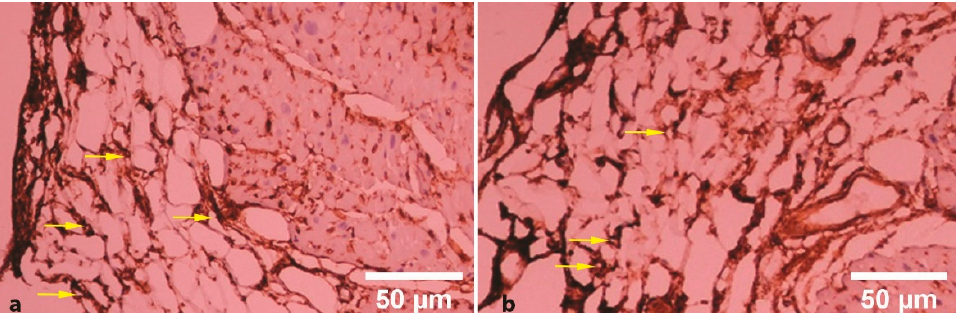
Figure 2. Immunohistochemical EAT analysis of the vessels (CD34 200 × ) in CAD patients without CHF ( a ) and CAD patients with CHF ( b ).